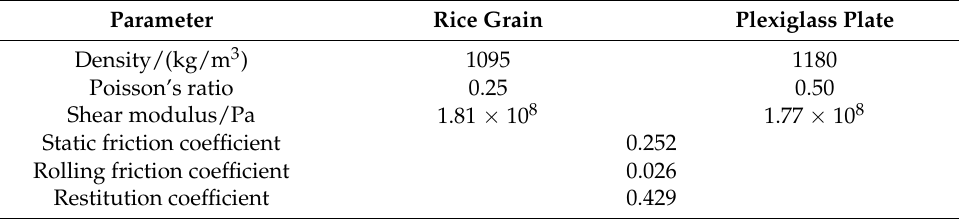
Table 6. Simulation parameters of rice grain and contact material.